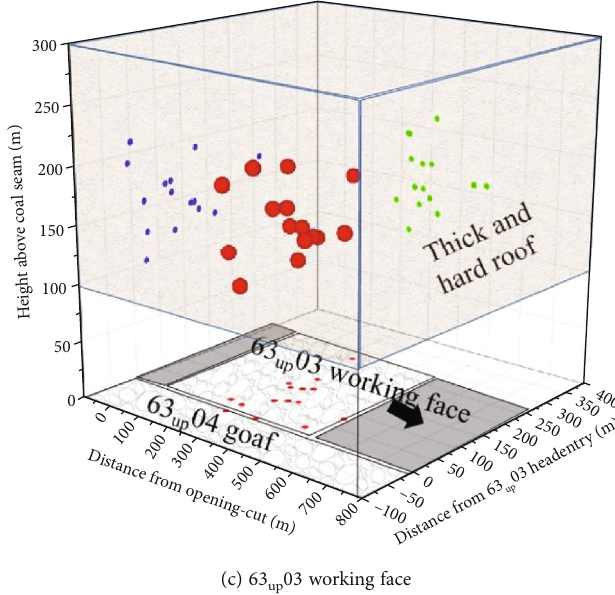
Figure 2: Occurrence times of high-energy mine earthquake events in the no. 6 mining district.